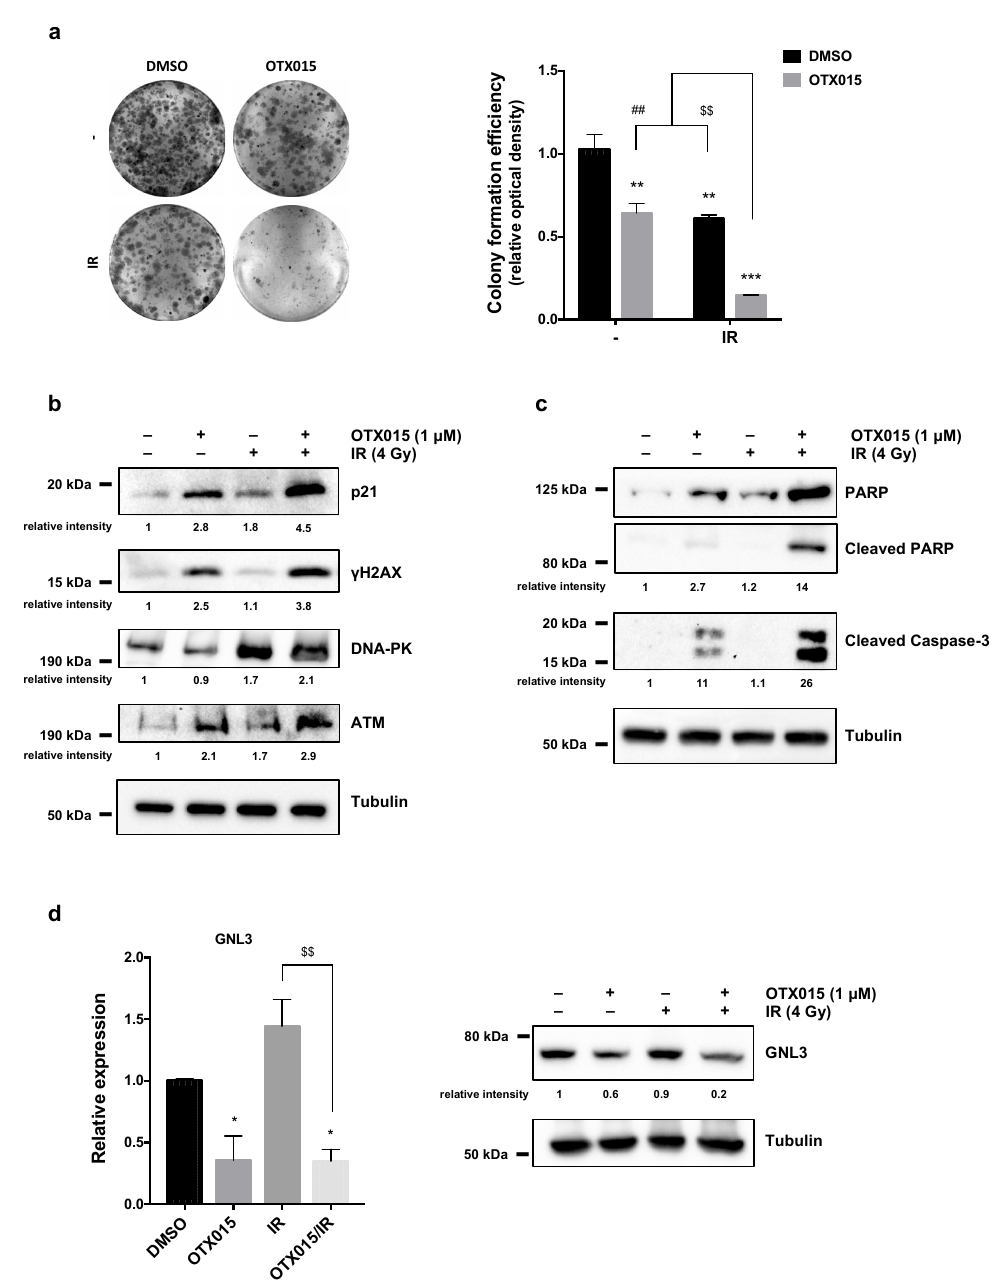
Figure 5. OTX015 exposure radiosensitizes OC cells by inducing apoptosis and inhibiting colony-forming ability and DNA damage repair. SKOV3 cells, treated with or without OTX015 (1 µM), were exposed or not to radiation (4 Gy). ( a ) Four h after IR, SKOV3 cells were plated at low concentration and cultured for 12 days. Representative images of colonies marked with crystal violet. Colony formation efficiency was obtained by crystal violet optical density from different assays, each in triplicate. Histograms are means ± SD. Statistical significances were calculated by two-way ANOVA: ** p < 0.01 and *** p < 0.001, vs. DMSO without IR; $$ p < 0.01 vs. DMSO/IR; ## p < 0.01 vs. OTX015 without IR. ( b ) WB of selected markers of cell cycle arrest (p21) and DNA damage/response ( γ H2AX, DNA-PK, ATM) in SKOV3 cells with or without OTX015 and/or IR. Tubulin served as normalizer and representative blot was shown. ( c ) WB of specific proteins involved in apoptosis (PARP, Caspase-3) were performed on SKOV3 cells treated with or without OTX015 and/or IR. Tubulin served as loading control and representative blot was shown. ( d ) q-PCR analysis (left panel) of GNL3 transcript levels in OTX015/IR-exposed SKOV3 cells, expressed as fold change over control cells (DMSO), set at 1. β -actin mRNA was used as endogenous control. Histograms indicate mean values ± SD of three independent experiments, each in triplicate. Statistical significances were calculated by two-way ANOVA (* p < 0.05 vs. DMSO; $$ p < 0.01 vs. IR). WB analysis (right panel) performed on protein extracts from OTX015/IR-exposed SKOV3 cells. Tubulin served as normalizer. The original Western Blot images can be found in Figure